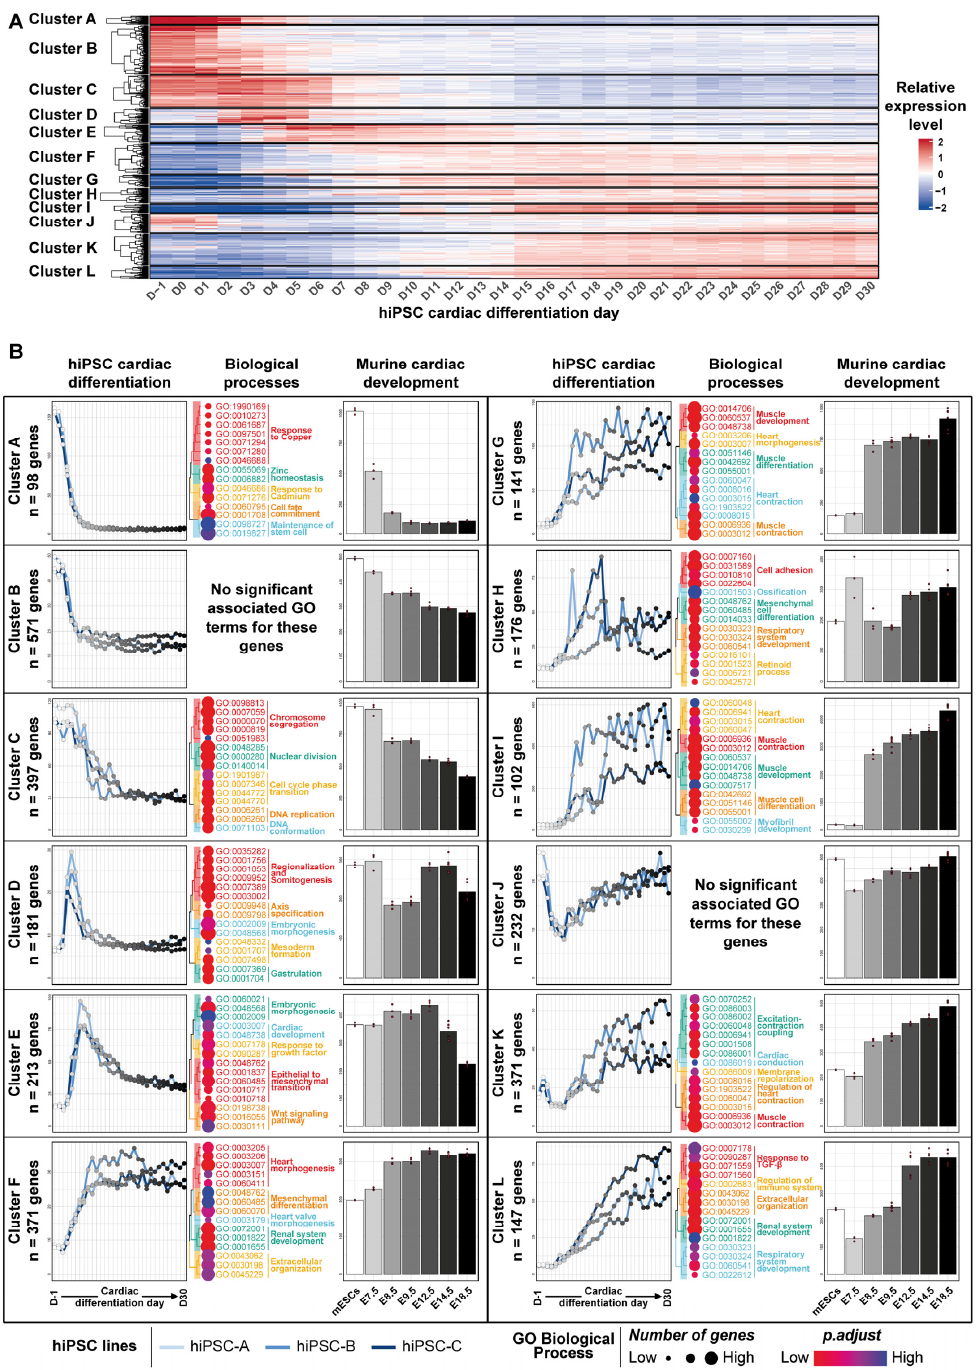
Figure 3. Expression profile and functional annotation of the top 3000 differentially expressed genes (DEGs) during hiPSC cardiac differentiation, and comparison with murine cardiac development gene expression dataset. ( A ) Heatmap displaying DEG expression levels. The entire data set was used to aggregate the genes into 12 clusters and the mean expression level of 9 replicates is represented. ( B ) For each cluster, average gene expression level during hiPSC cardiac differentiation (left panel for each cluster) and of their orthologs during murine cardiac development (mESCs to E18.5 stage, right panel for each cluster) are shown. Replicate gene expression levels were averaged for each hiPSC line (n = 3 per hiPSC line and per timepoint) and for murine data (n = 3 to n = 6 per timepoint, depending on the stage). The 15 most significantly related GO terms are displayed for each cluster on the middle panel. See also Figure